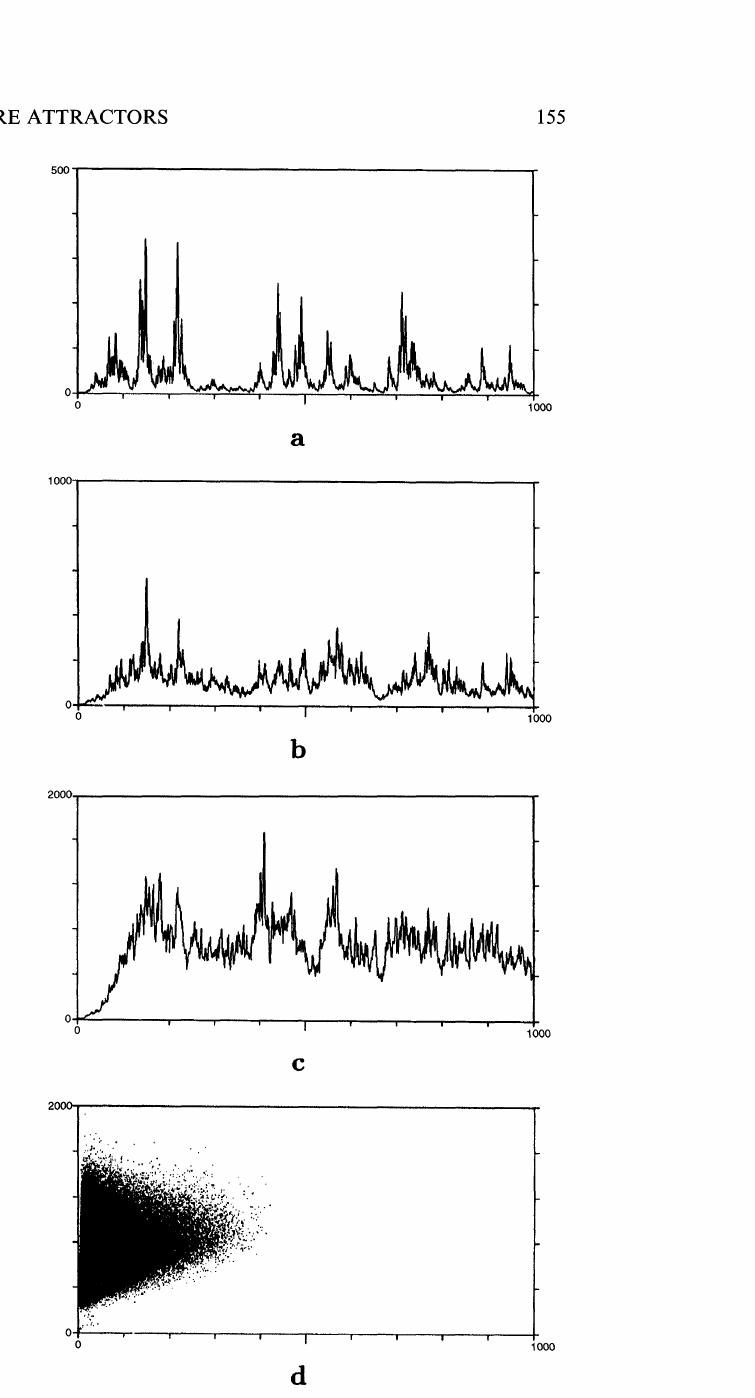
FIGURE 4 Several coupled flare attractors,